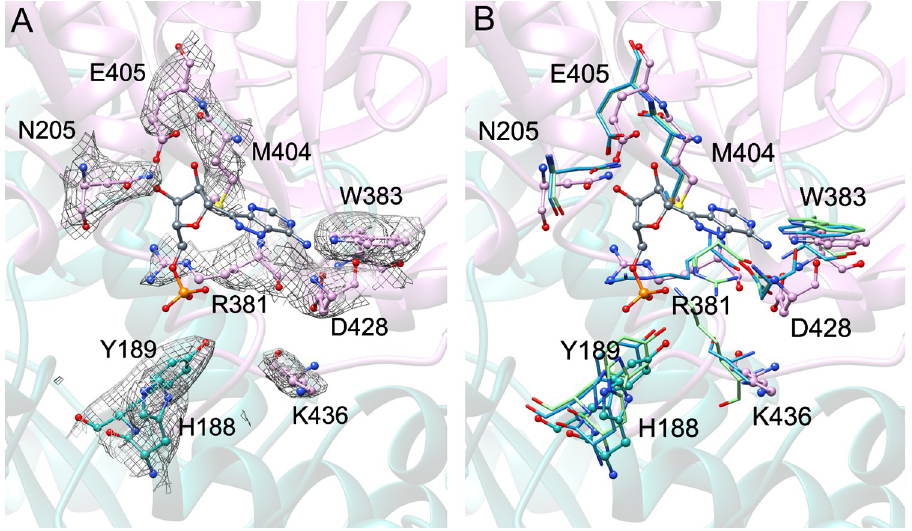
Fig 3. Active site of KpAmn. Presumed active site of KpAmn based on superposition with E . coli Amn (Protein Data Bank (PDB) entry 1T8S). Residues from two chains (A and B) make up the active site and are colored with green carbon atoms and yellow carbon atoms, respectively. The inhibitor formycin is shown with cyan carbon atoms and was positioned by superimposing the structure of PDB entry 1T8S over the solved structure of KpAmn. In these ball-and- stick models, oxygen atoms are shown in red, nitrogen atoms are shown in blue, sulfur atoms are shown in yellow, and the phosphate atoms are shown in orange. In panel A, the electron density is from a sharpened map and is contoured at 3 σ . In panel B, the corresponding E . coli residues are show as sticks only in teal (without ligand) and green (with ligand).